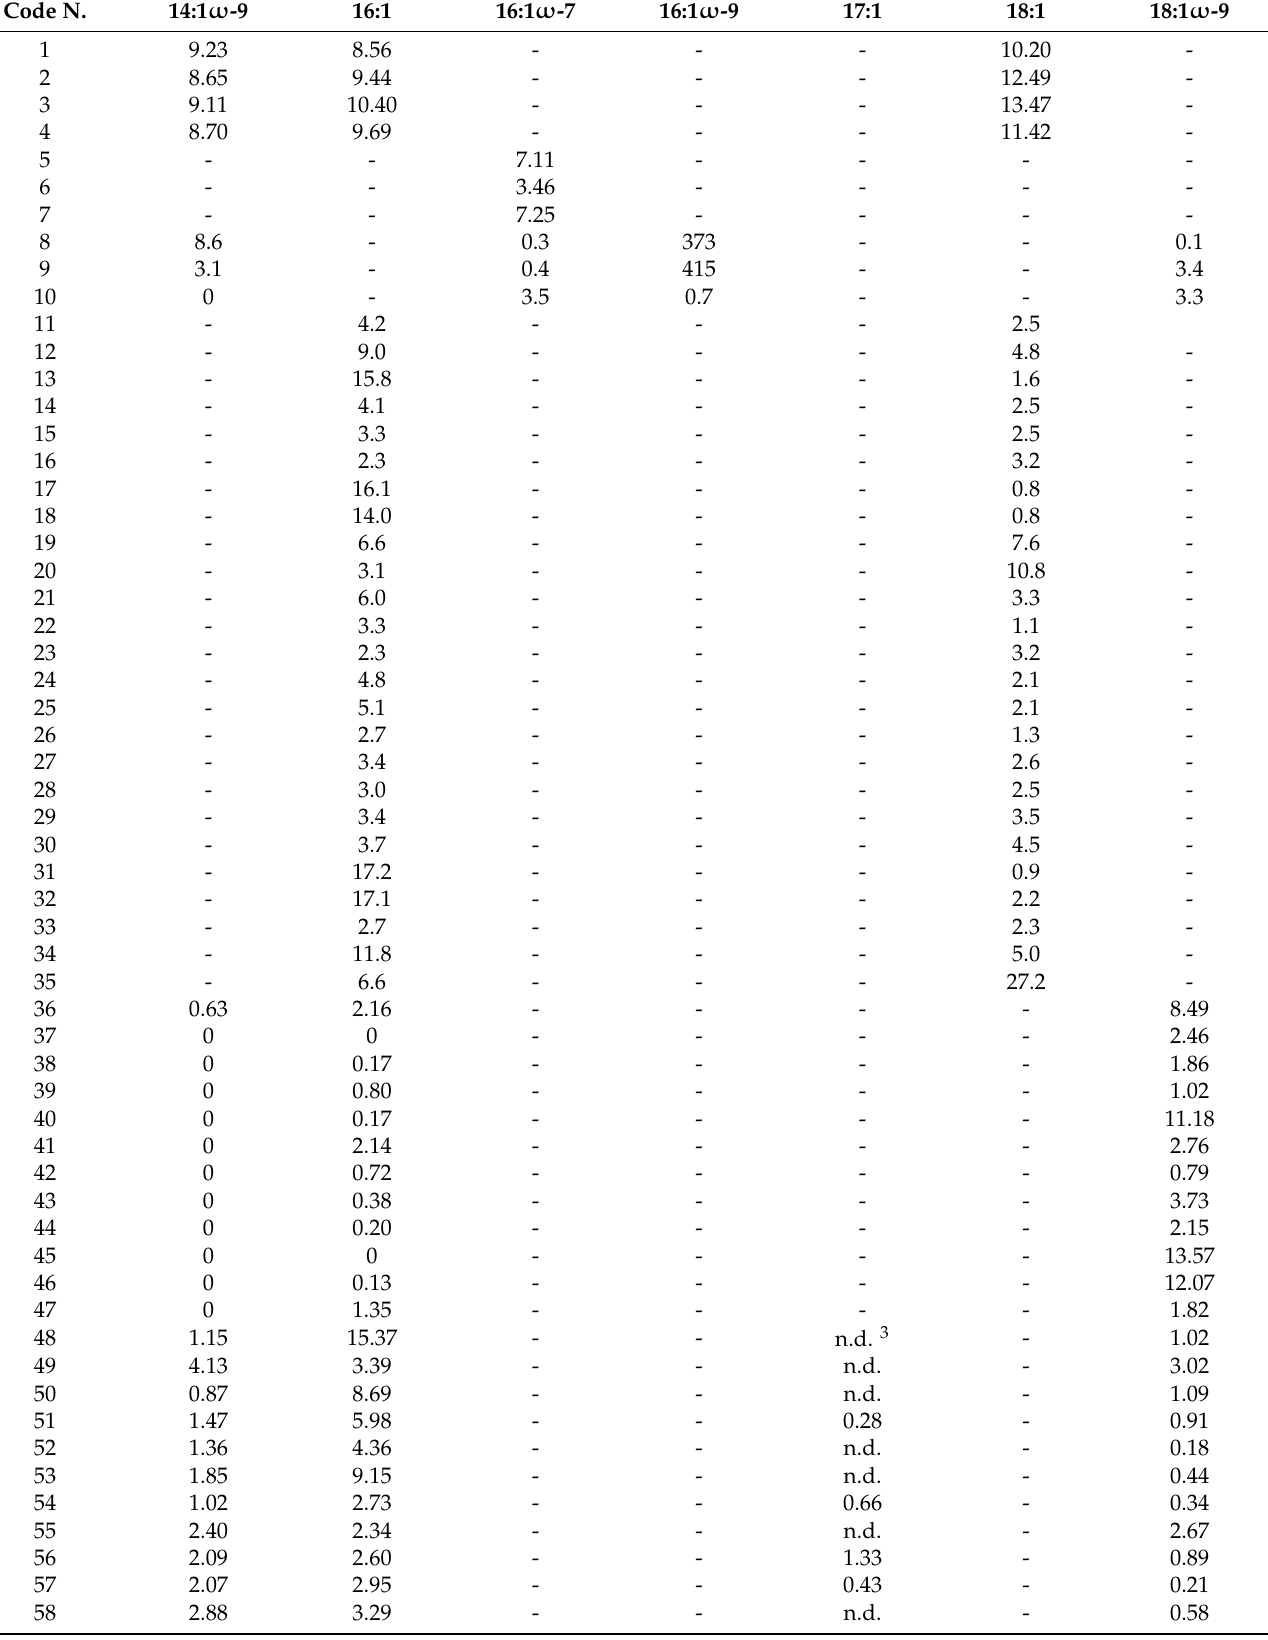
Table 3. Monounsaturated fatty acid composition of cyanobacteria selected for this review 1,2 . Code